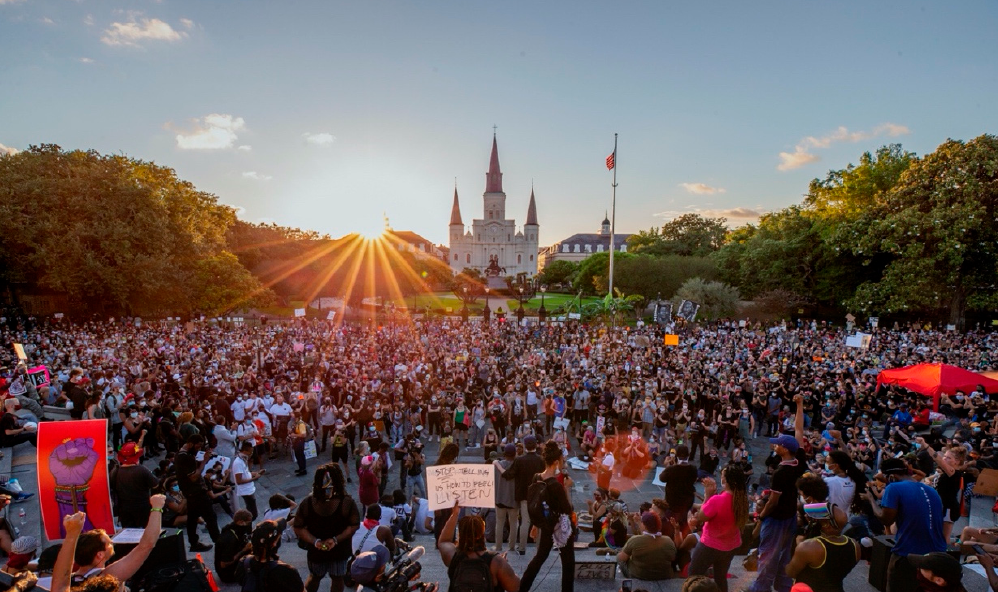
Figure 4. Black Lives Matter protest at Jackson Square in New Orleans on 5 June 2020. Photograph by David Grunfeld, courtesy of NOLA.com, The Times Picayune | The New Orleans Advocate. In 1851, the city of New Orleans renamed Place d’Armes “Jackson Square” in honor of Andrew